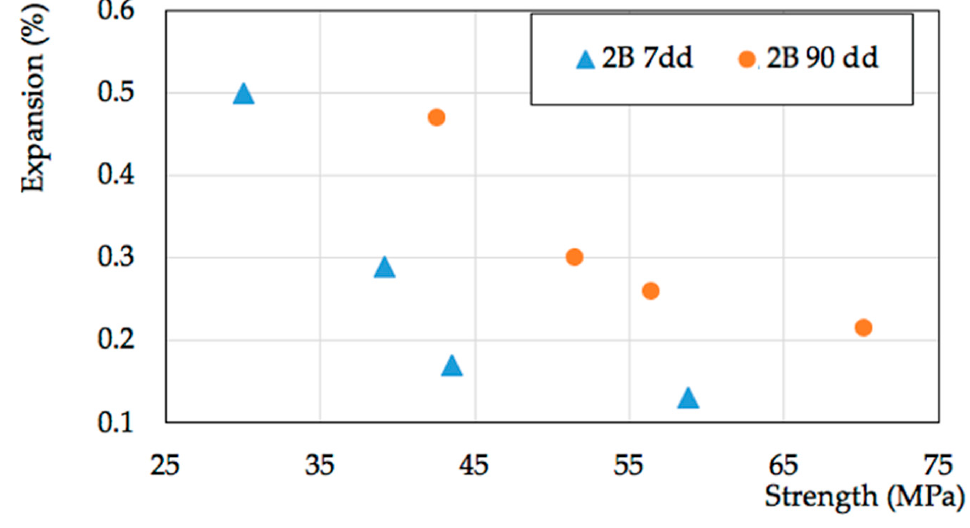
Figure 10. Expansion vs. mechanical strength for 2B mortars.